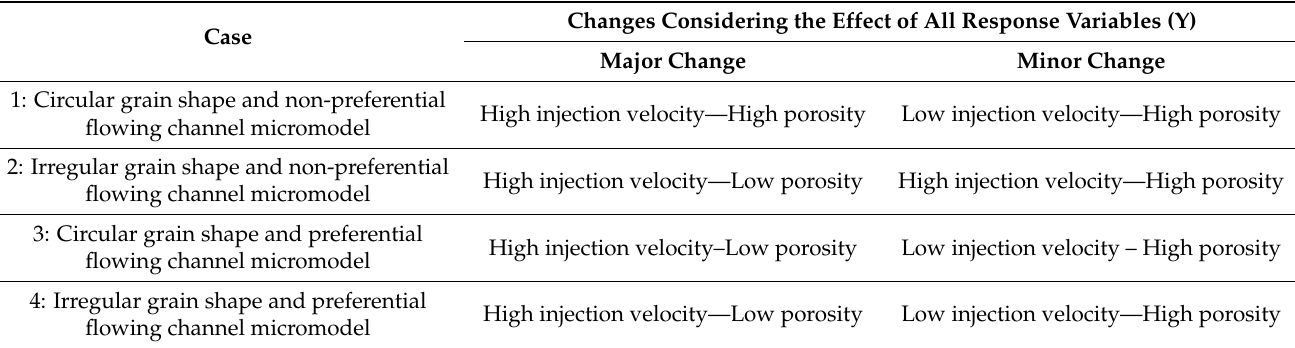
Table 8. Conditions of injection velocity and porosity that yield the highest values of χ Total,IFT